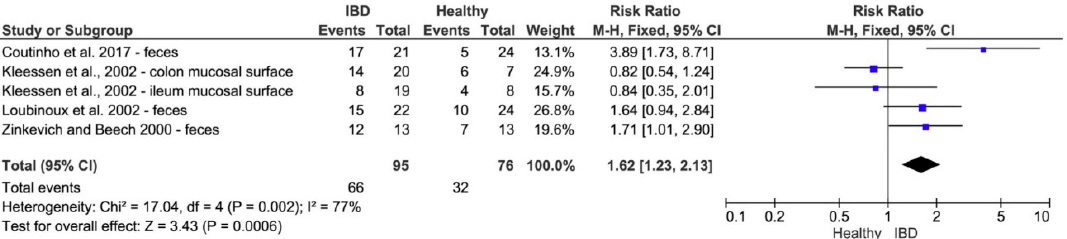
Figure 7. Forest plot showing the relation between the presence of sulfate-reducing bacteria (SRB) and the prevalence of inflammatory bowel diseases (IBD) [21].